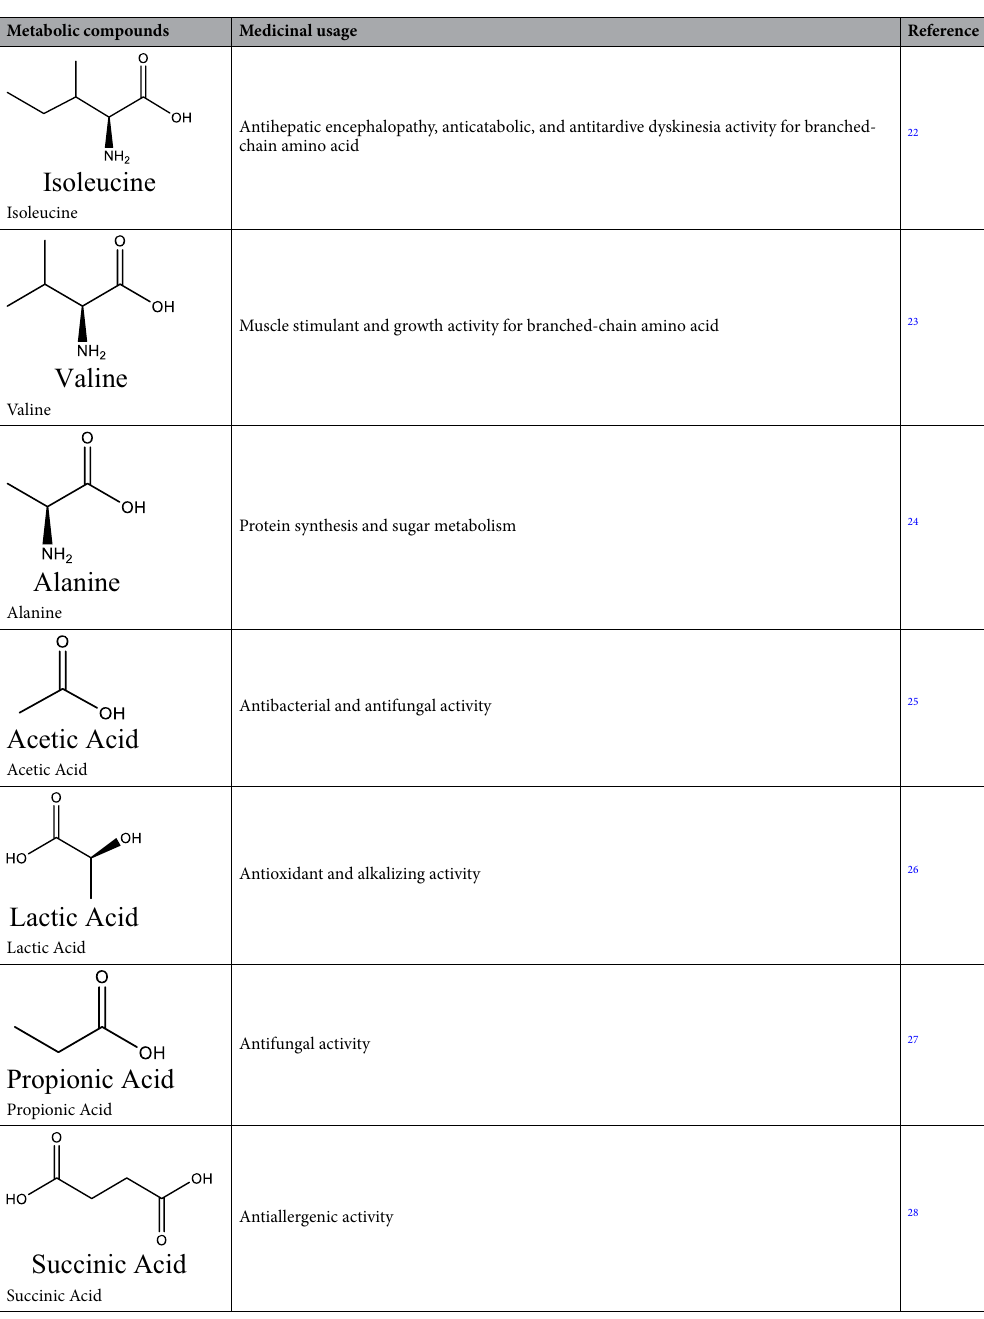
Table 2. Compounds found in leaves ethyl acetate extract after analysed by 1 H NMR spectroscopy.